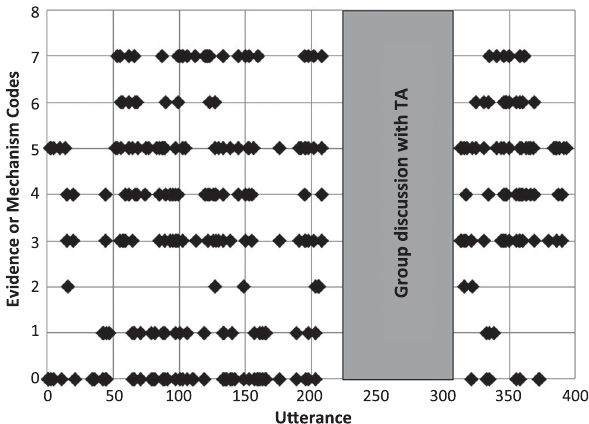
FIG. 2. Graph of student use of evidence and